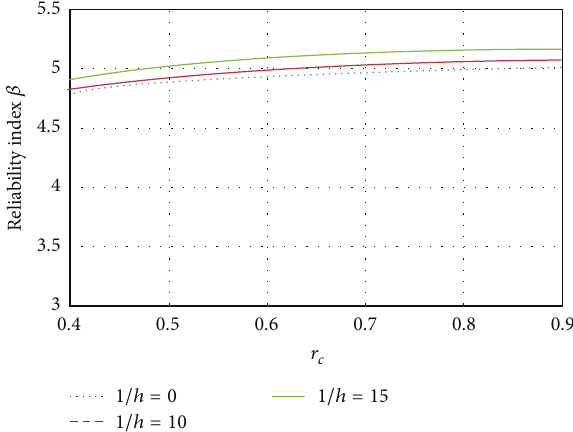
Figure 9: Reliability corresponding to compression plus bending mode ( 𝑒 = 𝑒 𝑏 ).